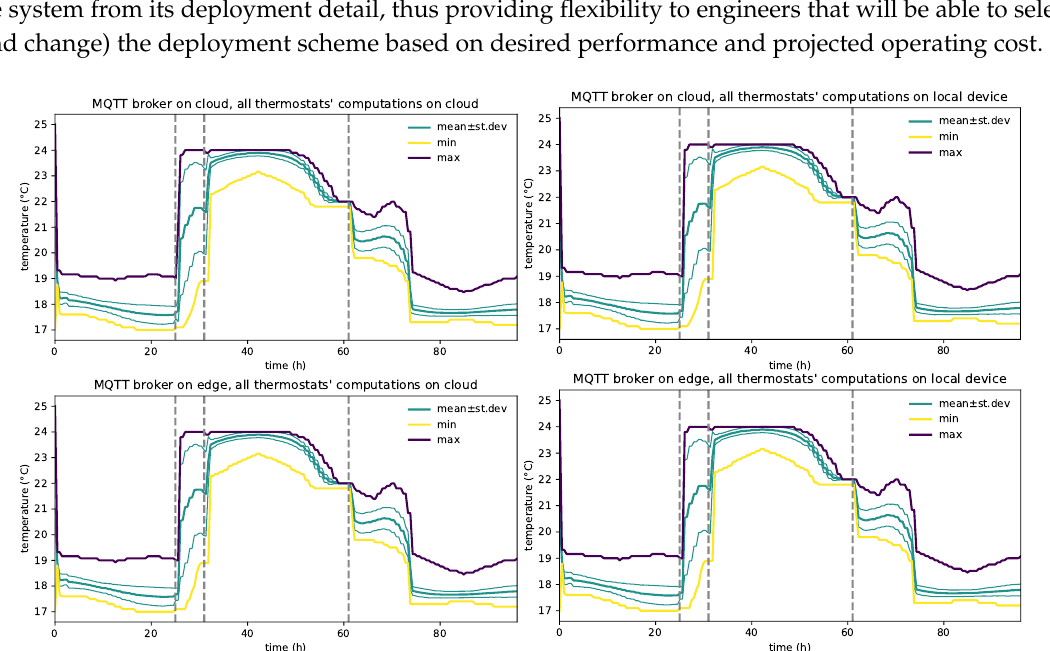
σ [ T ] (aquamarine), T max (purple), and T min (yellow) in the following Figure 10. Evolution of E [ T ] ± conditions: B = cloud (MQTT broker hosted on the cloud) in the top charts; B = edge (MQTT broker hosted on the edge), in the bottom charts; P l = 0 (all thermostat computation hosted on the cloud), in the left-hand column; P l = 1 (all thermostat computation hosted on the local device), right-hand column. Every delay is set to the second lowest value in the set (usually resembling common operating conditions). Vertical dashed gray lines depict, from left to right: rainfall arrival on the northern part of the city, rain falling on the total city area, and rainfall conclusion. The functional behavior of the system is consistent regardless of the deployment strategy: results are very similar across the board. Very small differences come from different network performance (mostly due to diverse network latency) and from the randomness inherent to the simulation. The system reacts to changes in the detected PM 10 level by adjusting the temperature and allowing higher temperatures to be set when air pollution levels are sufficiently low. σ [ T ] increases when rainfall hits only part of the city. This is because thermostats located in the area subject to the rainfall allow higher temperatures to be set, while the remainder of devices remains on the pre-rain levels, thus raising